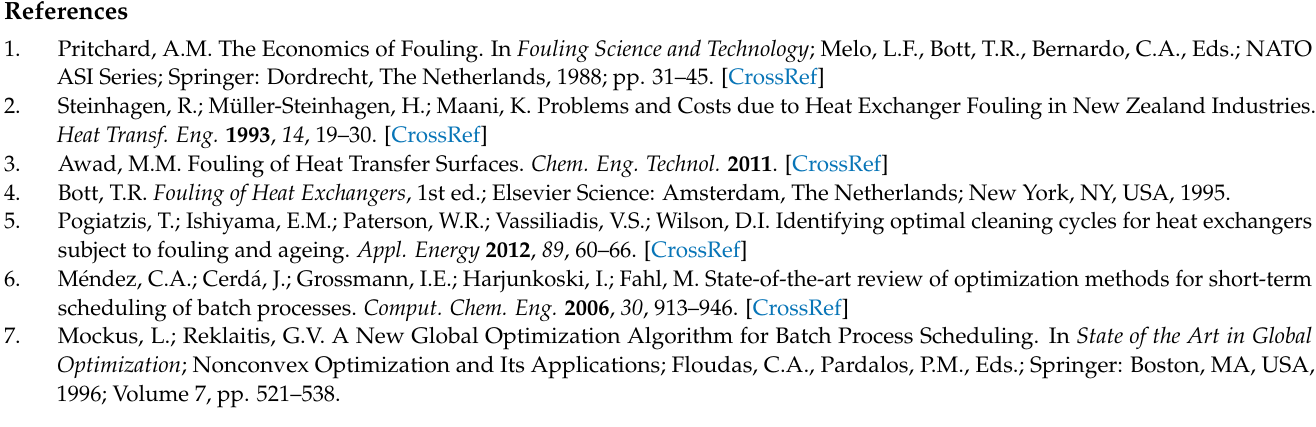
For α , β < 1 the behavior is opposite and is defined as the anti-mode, or the lowest point of the probability density curve. For α = β , the expression for the mode simplifies to 1/2, showing that for α = β > 1 the mode (respectively anti-mode when α , β < 1), is at the center of the distribution: it is symmetric in those cases as can be seen in the figure.